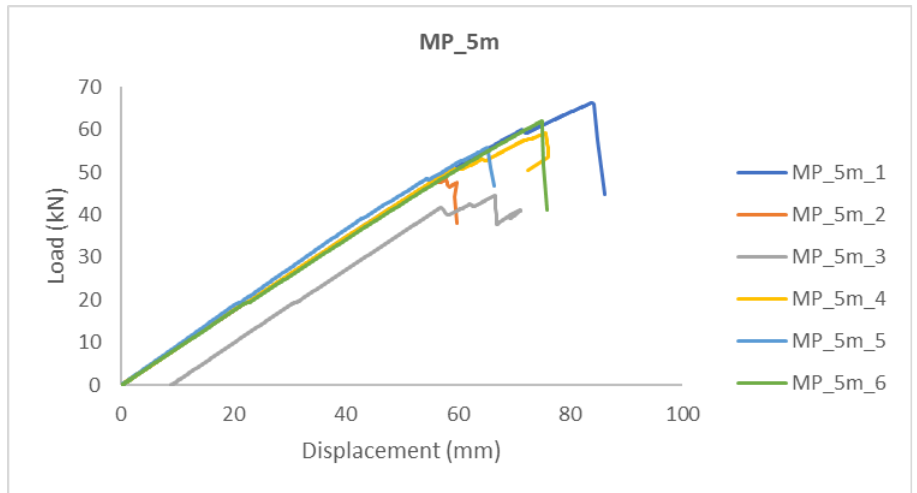
Figure 6. Load-displacement—normal (non-perforated) samples.